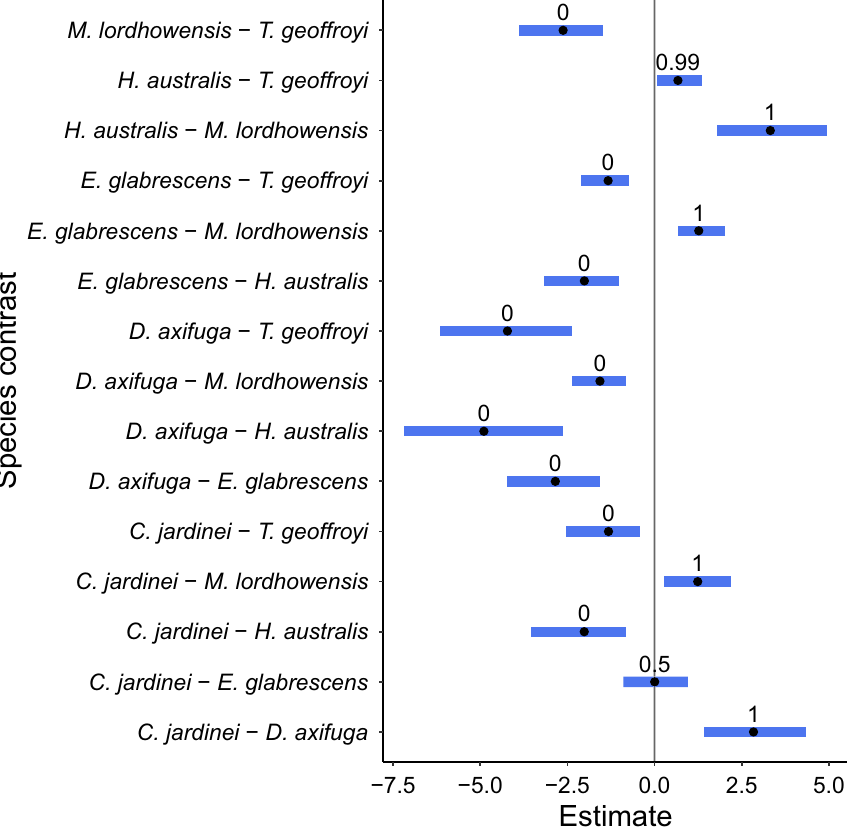
Figure 1. By species ( Catalaphyllia jardinei , Duncanopsammia axifuga , Euphyllia glabrescens , Homophyllia cf. australis , Micromussa lordhowensis , Trachyphyllia geoffroyi ) pairwise comparison of species coefficient estimate on the non-linear ‘ c ’ parameter, where blue bars represent 95% C.I. (credible interval), black point represents estimate of effect, and number above blue bar represents the probability that P > 1, where terms outside the 5–95% interval indicate statistical